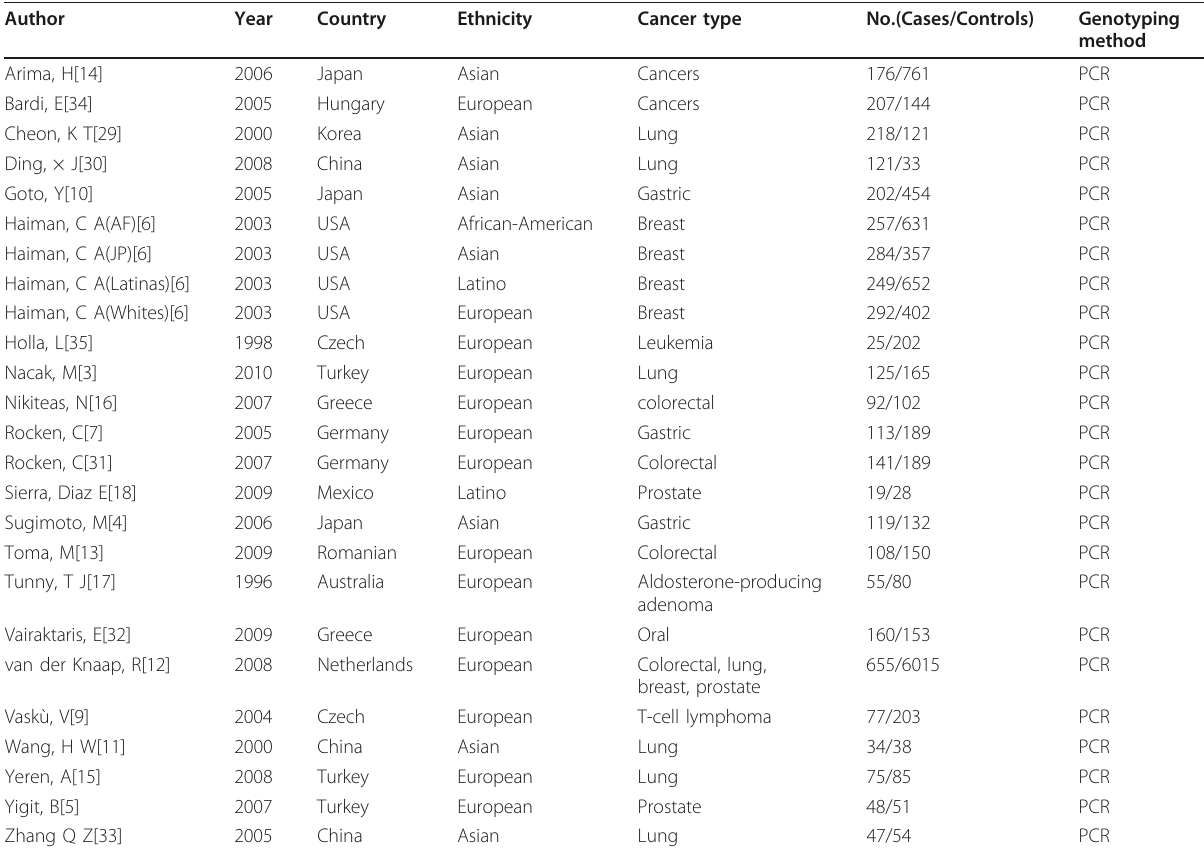
Table 1 Characteristics of case-control studies included in